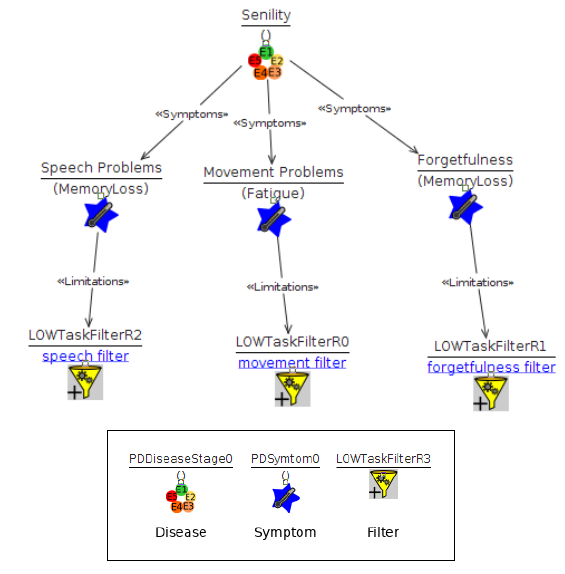
Figure 1. Modeling the symptoms.